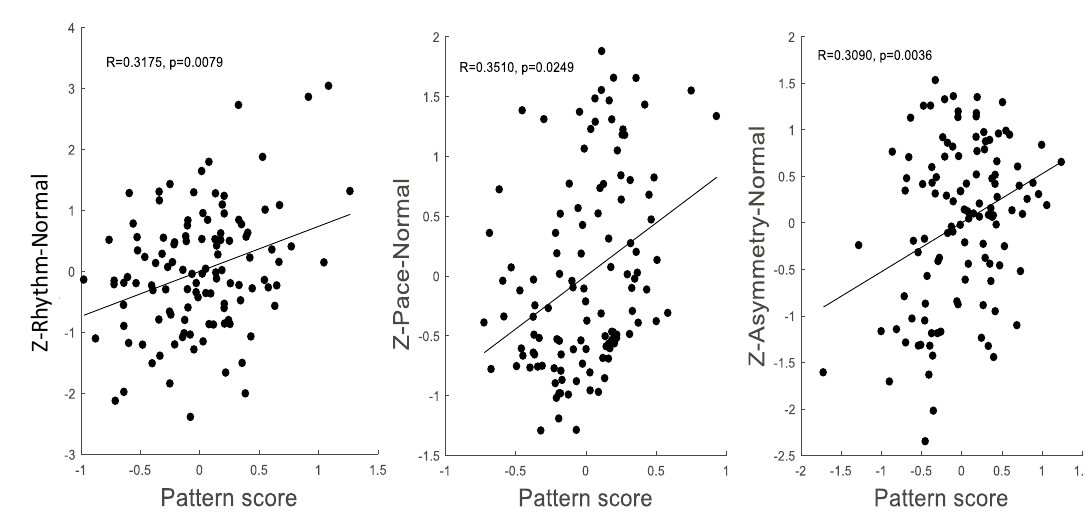
Figure 1. The three patterns which were derived such that their pattern scores correlate maximally with the mobility